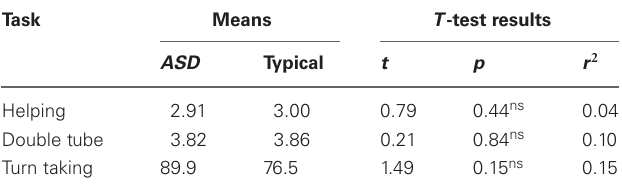
Table 3 | Results for helping and cooperation tasks. Task